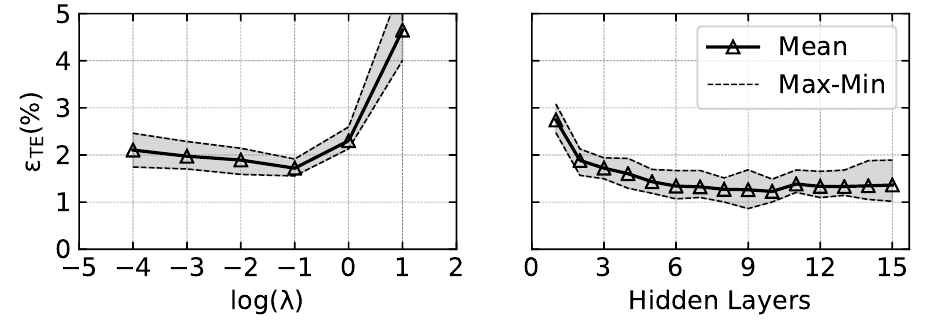
Figure 4. Hyperparameters study.